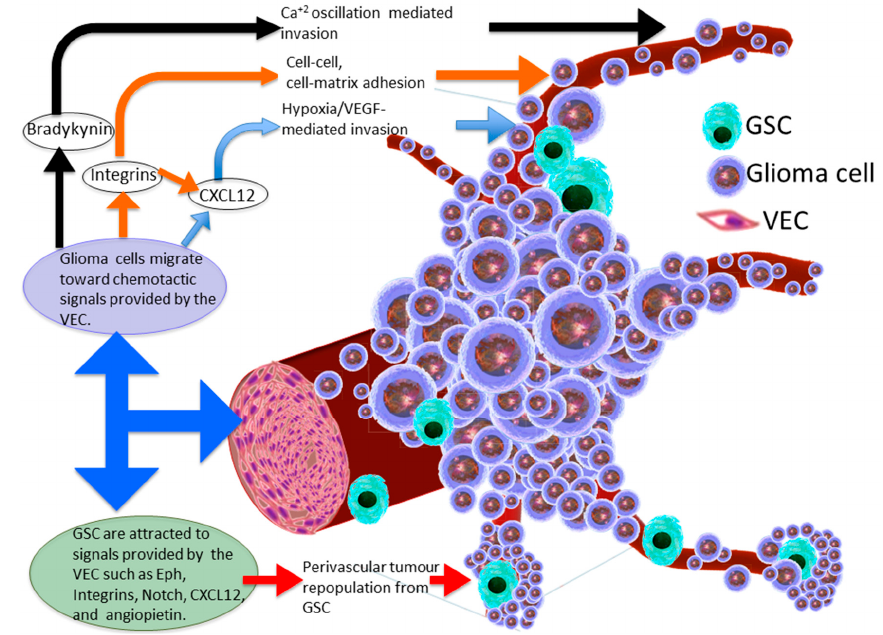
Figure 1. The glioma invasive perivascular niche. Characteristic perivascular satellitosis occurs due